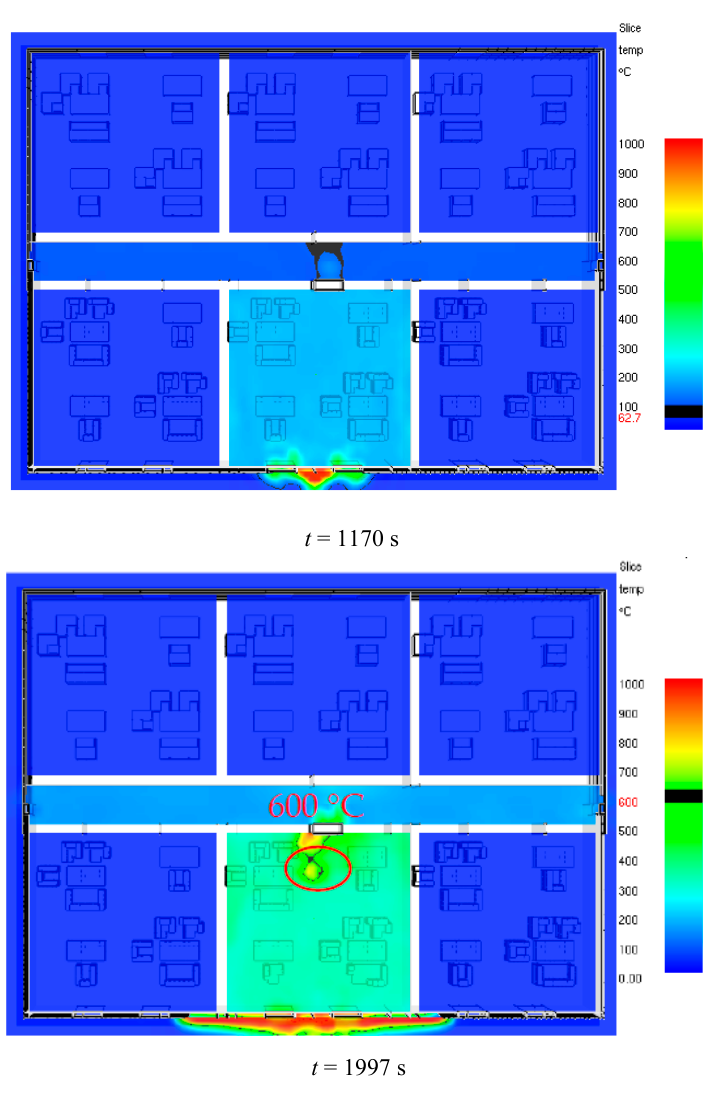
Figure12. Smoke temperature distribution at eighth floor obtained by LES. Figure 12. Smoke temperature distribution at eighth floor obtained by Table 7. The dangerous time caused by smoke temperature in different floors.